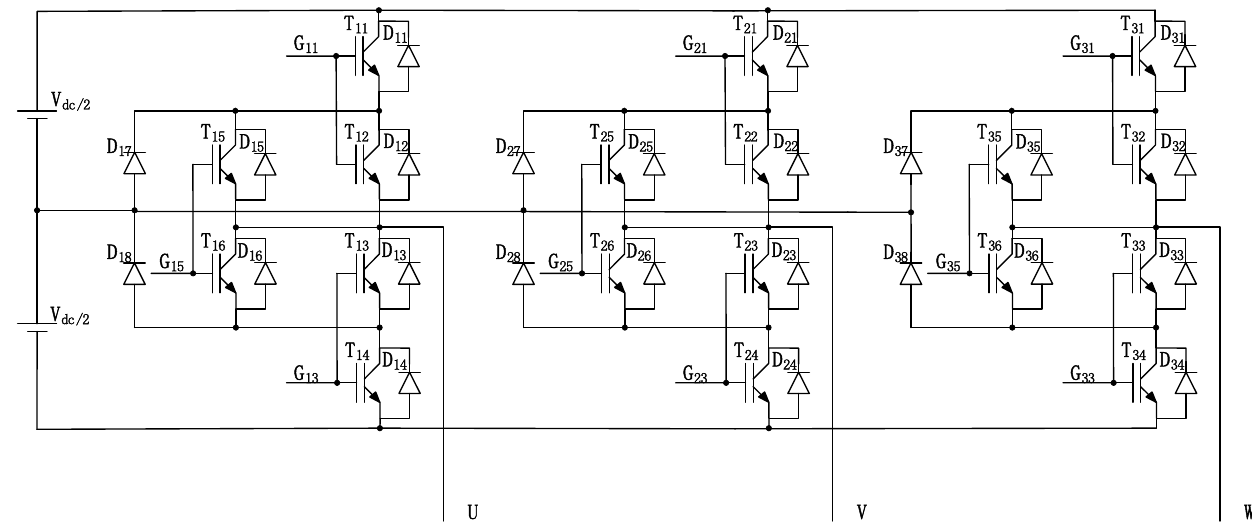
Figure 2. The ID-NPC (improved diode neutral-point-clamped) topology.